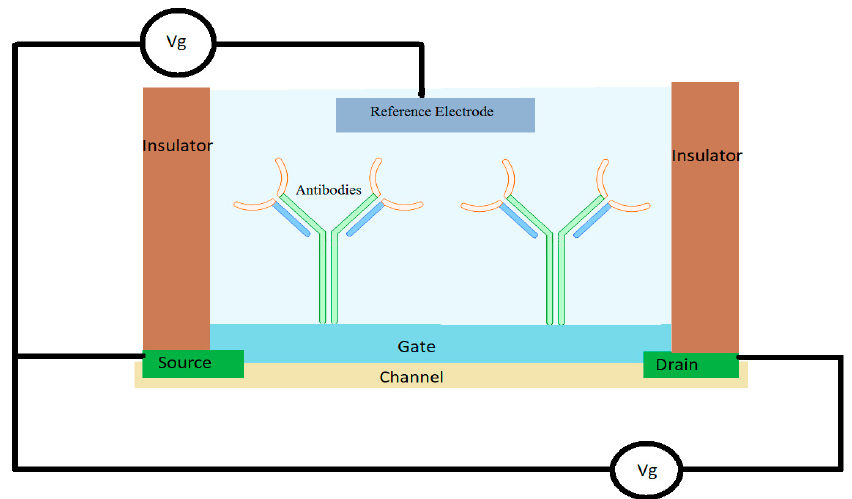
Figure 8. A schematic for a field effect transistor (FET) -based affinity based sensor for antibody–antigen interaction.